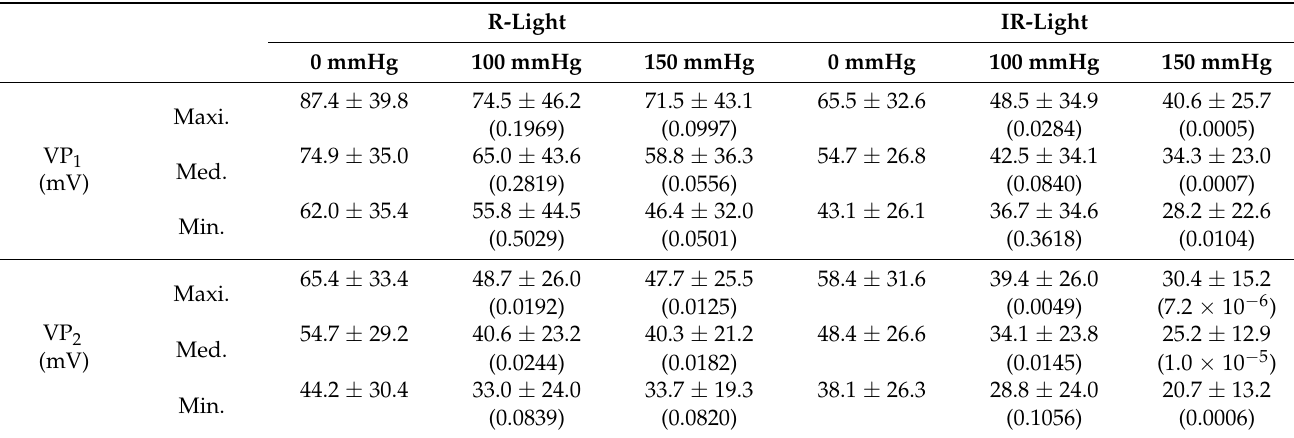
Table 3. Statistical analyses of six parameters, being maximum, median, and minimum values between the negative group (0 mmHg) and positive groups (100 mmHg and 150 mmHg) by t -test. A p -value of less than 0.05 is highlighted in